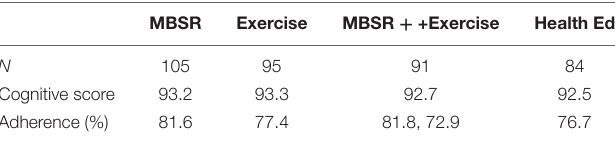
Table 2 . Cognitive performance and adherence data for the 4 intervention groups are listed in Table 1 .